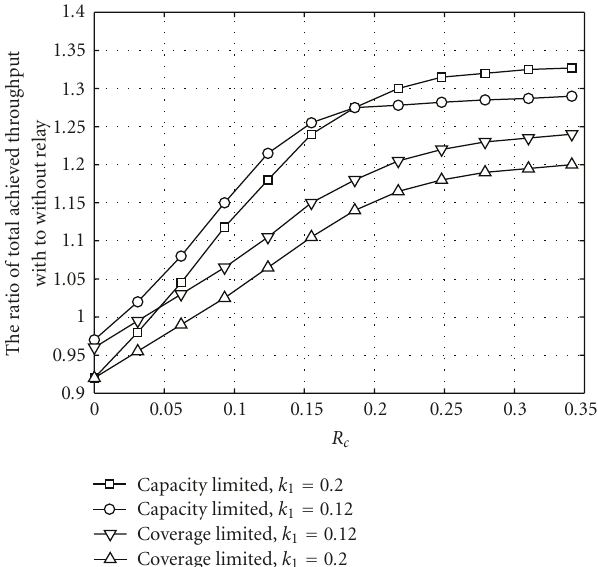
Figure 9: The total achieved throughput with and without relaying versus the relays’ coverage.